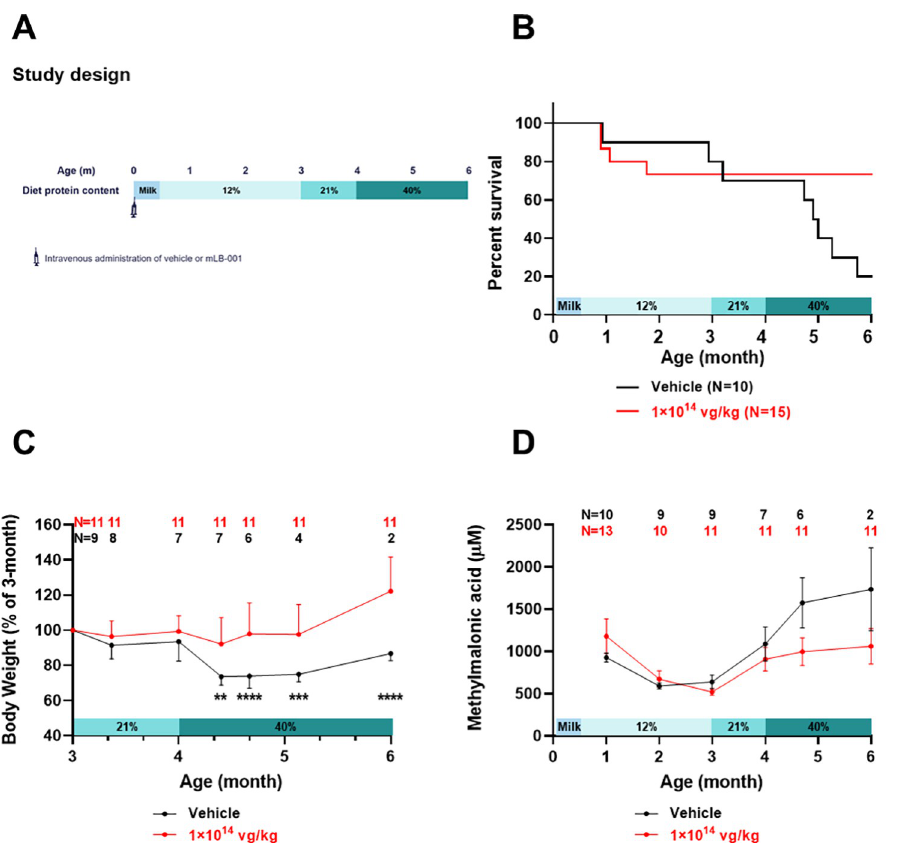
Fig 2. Effect of the high protein diet challenge on MMA mice treated with vehicle or 1 × 10 14 vg/kg mLB-001 on PND 1. (A) Study design. Animals were dosed with vehicle or mLB-001 on PND 1. Nursing dams were kept on the standard 21% protein diet until PND 14, when the diet was switched to a 12% protein diet. Pups were weaned on PND 28 and maintained on the 12% protein diet. At 3 months of age, all surviving animals were switched to the standard chow with 21% protein content and then to a 40% protein diet at 4 months of age. Necropsy was performed at 6 months of age. (B) Kaplan-Meier survival curves of MMA mice. Log-rank test demonstrated significantly better survival of the mLB-001-treated group than the vehicle-treated group ( P < 0.05). (C) Change in body weight of MMA mice in response to the high protein diet challenge. The body weight of each Mmut-deficient animal was normalized to its weight at the introduction of the 21% protein diet. Females and males were combined due to a lack of significant difference. Animal numbers at each timepoint are indicated above the graph. �� P < 0.01, ��� P < 0.001, ���� P < 0.0001, mixed-effects analysis with multiple comparisons between vehicle- and mLB-001-treated groups at indicated timepoints. (D) Circulating methylmalonic acid levels in MMA mice. The mLB-001-treated animals maintained lower levels than the vehicle-treated animals in response to the high protein diet